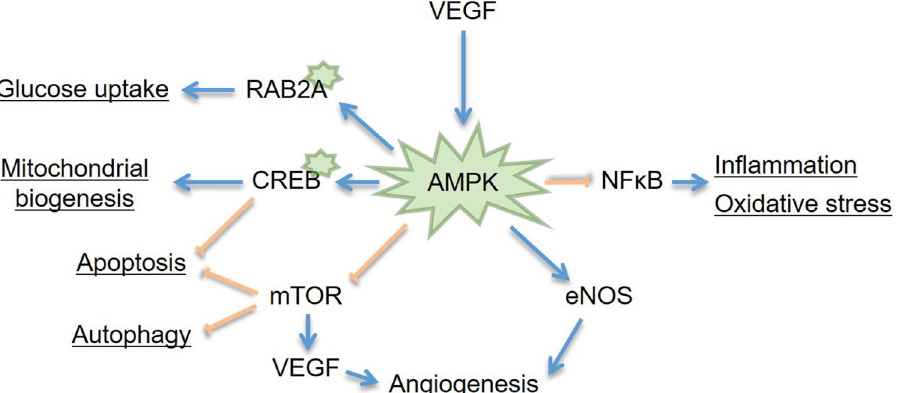
Figure 4. Proposed scheme for AMPK signaling pathway. VEGF : vascular endothelial growth factor; AMPK : AMP-activated protein kinase; RAB2A : Ras-related protein 2A; CREB : CAMP responsive element binding protein 5; mTOR: mammalian target of rapamycin; eNOS: endothelial isoform of nitric-oxide synthase; NFκB: nuclear factor kappa-light-chain-enhancer of activated B